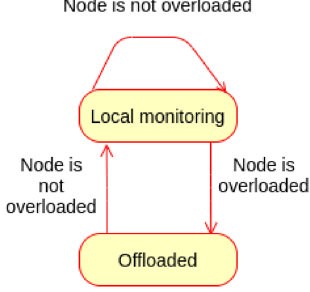
Figure 16. State machine of SCM monitoring and